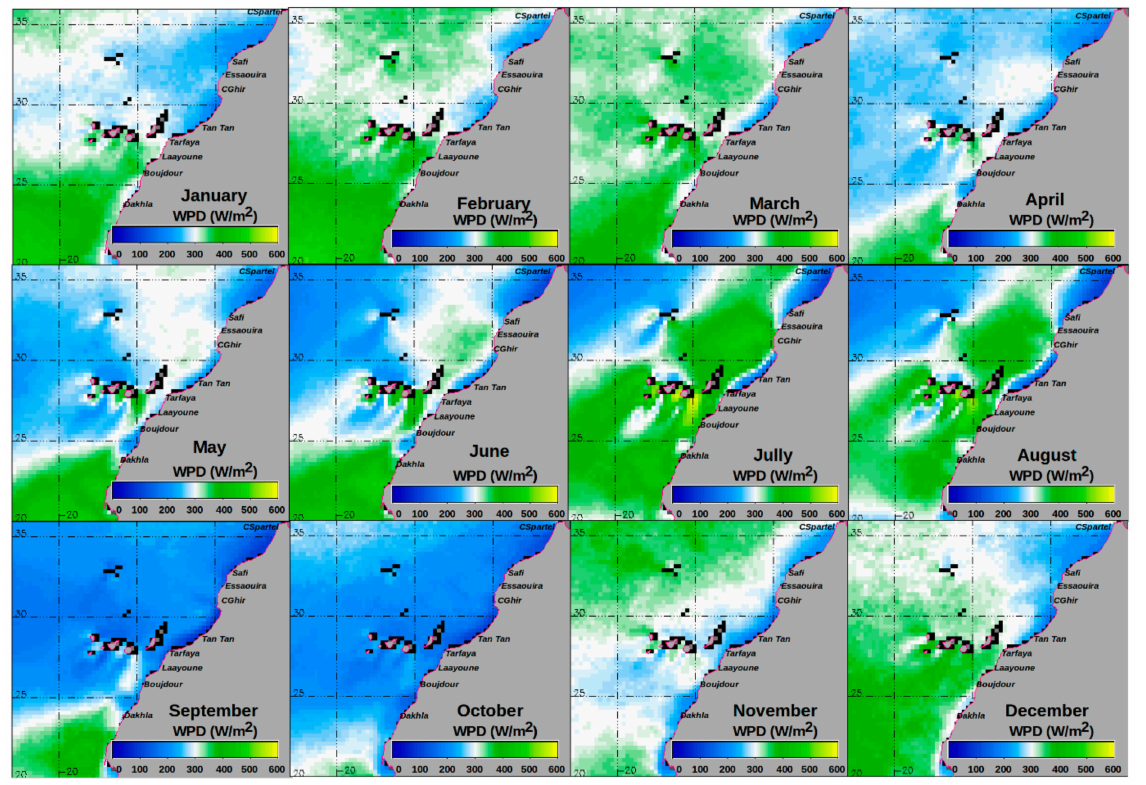
Figure 9. Monthly climatology of wind power density (WPD, W/m 2 ) for the period 2008–2017 at 80 m